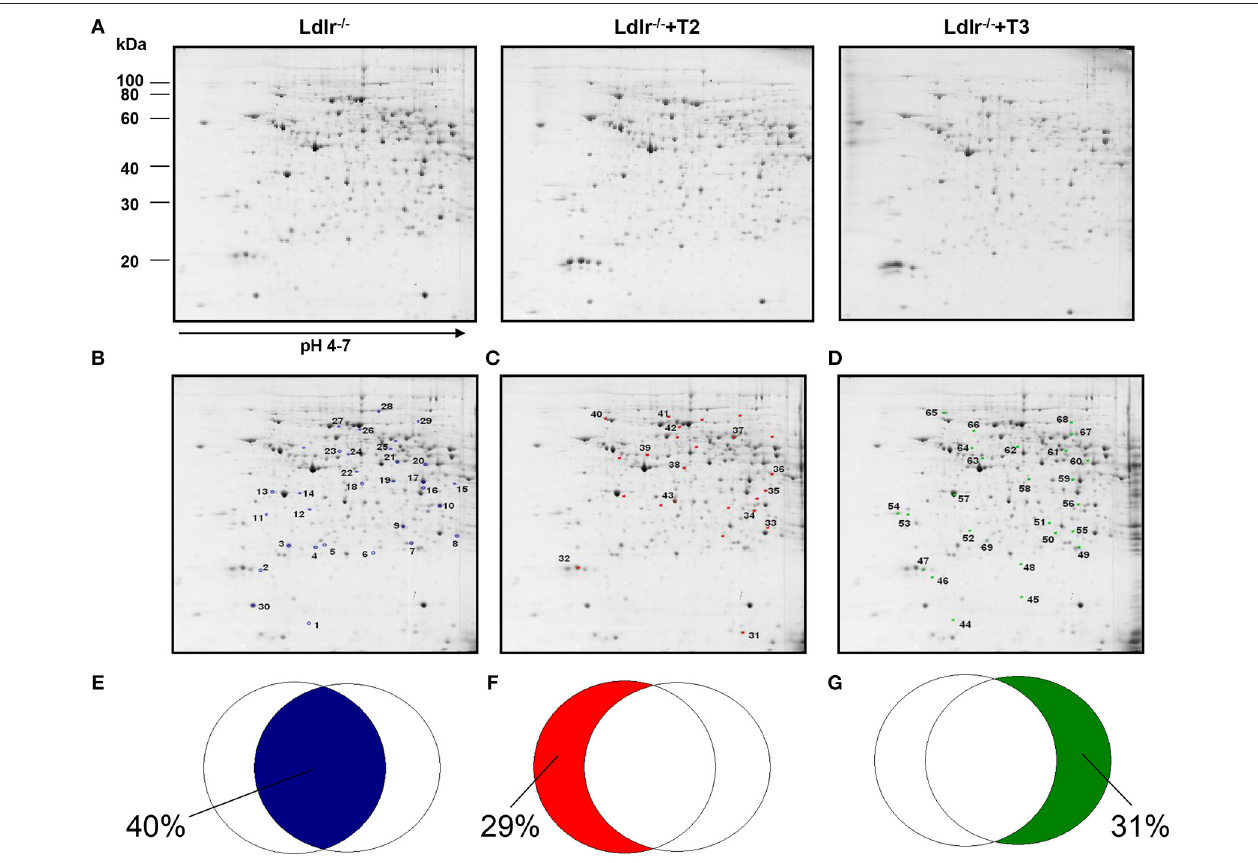
FIGURE 1 | Effects of T3 and T2 on the hepatic proteome in Ldlr − / − mice. (A) Representative 2D-E Coomassie Blue stained maps of total liver soluble proteins extracted from Ldlr − / − , Ldlr − / − + T2, and Ldlr − / − + T3 mice and separated on 17 cm/pH 4–7 IPG strips in the first dimension and on 12% SDS-PAGE in the second. Spotted and identified proteins among those with a density that differed significantly (by at least 0.5- or 2-fold; p < 0.05) between Ldlr − / − and either Ldlr − / − + T2 or Ldlr − / − + T3 (blue spots) (B) , Ldlr − / − and Ldlr − / − + T2 only (red spots) (C) , and Ldlr − / − and Ldlr − / − + T3 only (green spots) (D) . Overlapped circles represent the total amount of differentially expressed proteins between the experimental groups. The blue area represents the percentage of proteins affected by both T2 and T3 (iodothyronines’ common proteomic effect in liver of Ldlr − / − mice) (E) ; the red area represents the percentage of proteins affected only by T2 treatment (F) ; the green area represents the percentage of proteins affected only by T3 treatment (G)